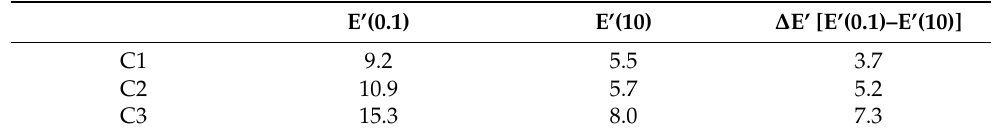
Figure 3. Storage modulus as a function of dynamic strain amplitude. Table 5. Magnitude of Payne